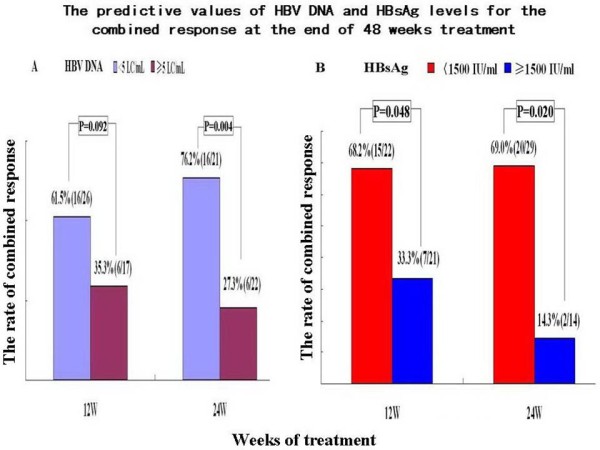
The predictive values of HBV DNA and HBsAg levels during treatment for the combined response (HBeAg loss and undetectable HBV DNA) at the end of 48 weeks treatment. LC/ml: Log10 copies/ml.